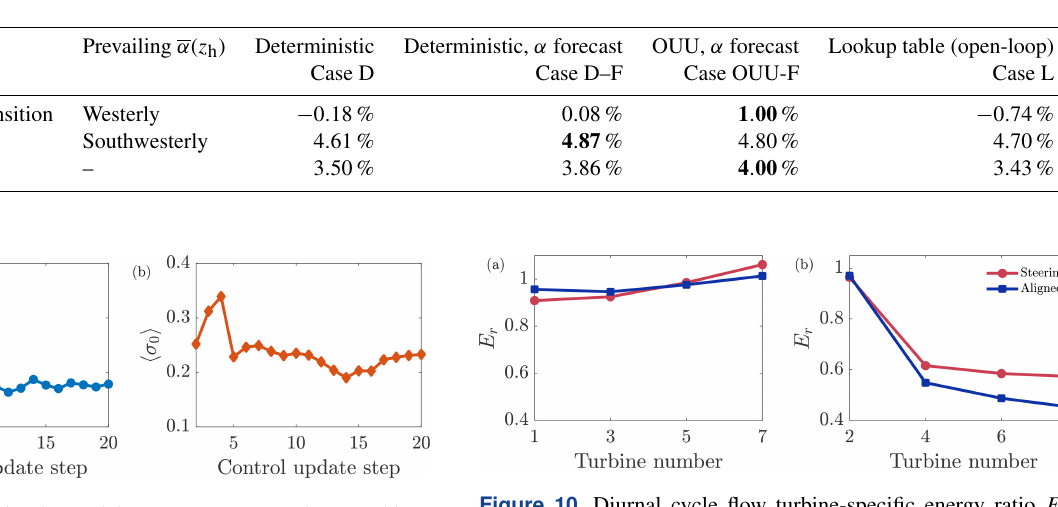
Figure 9. Estimated wake model parameters averaged over turbines 1, 3, and 5 as a function of the control update step. (a) Wake spread- ing coefficient k w . (b) Gaussian wake proportionality constant σ 0 .